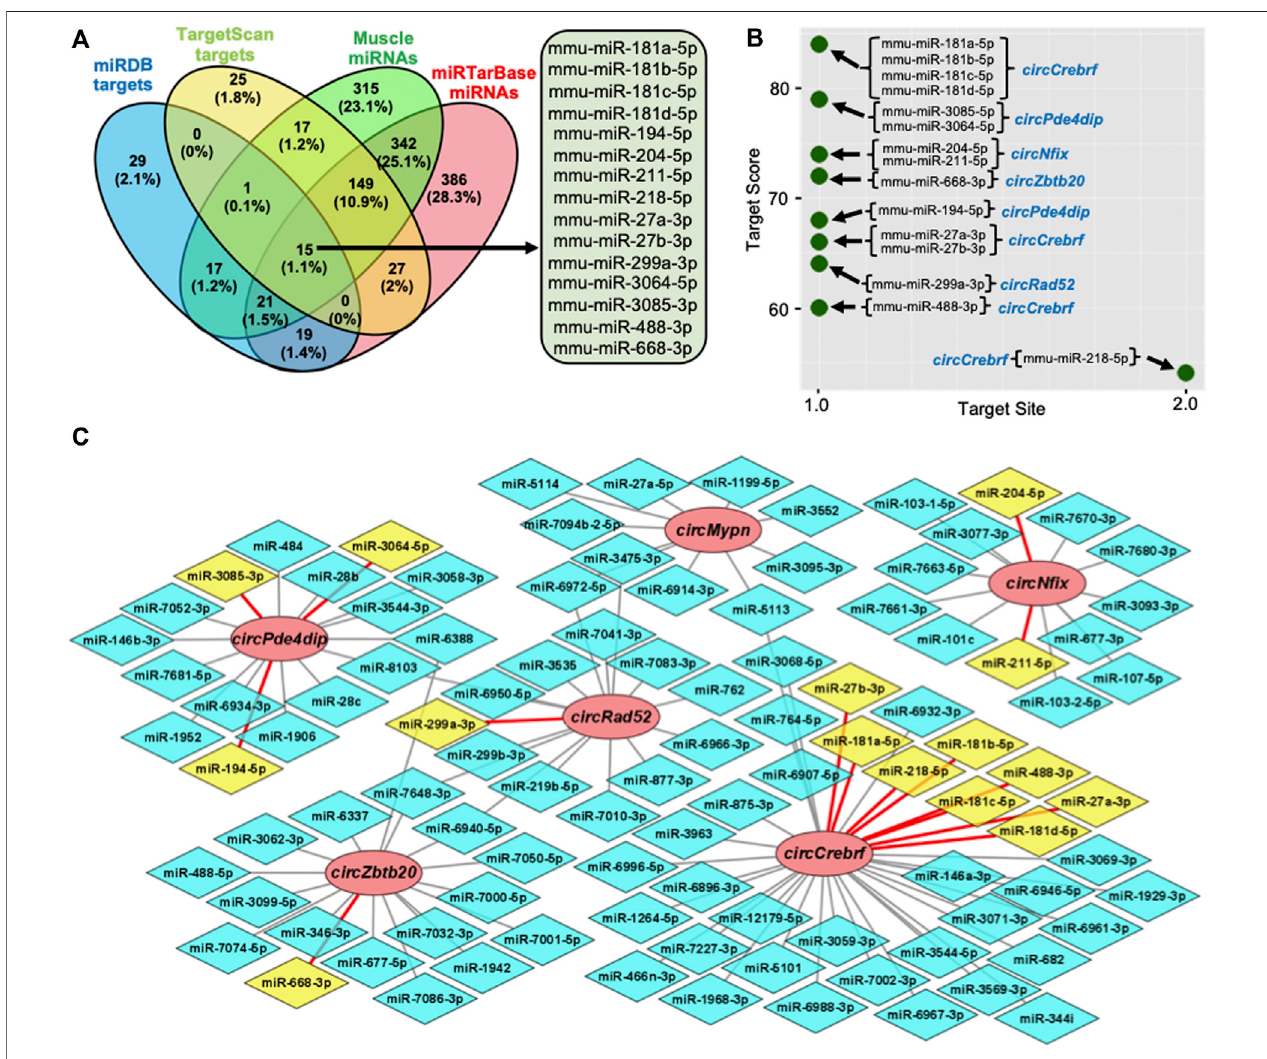
FIGURE3| PredictionofthecircRNA-miRNA-mRNA regulatorynetworkinskeletal muscle. (A) .Venndiagram depiction ofthemusclemiRNAs predictedtotarget thevalidatedcircRNAsandvalidatedbymiRTarBase. (B) .PredictedmiRNAtargetsofthesixvalidatedcircRNAsusingmiRDBcustompredictiontool. (C) .ThecircRNA- miRNAregulatorynetworkwasconstructedandvisualizedonCytoscape.CirclenodesrepresentcircRNAs,hexagonnodesrepresentmiRNAs,andyellowmiRNAswith red edges are functional miRNAs.